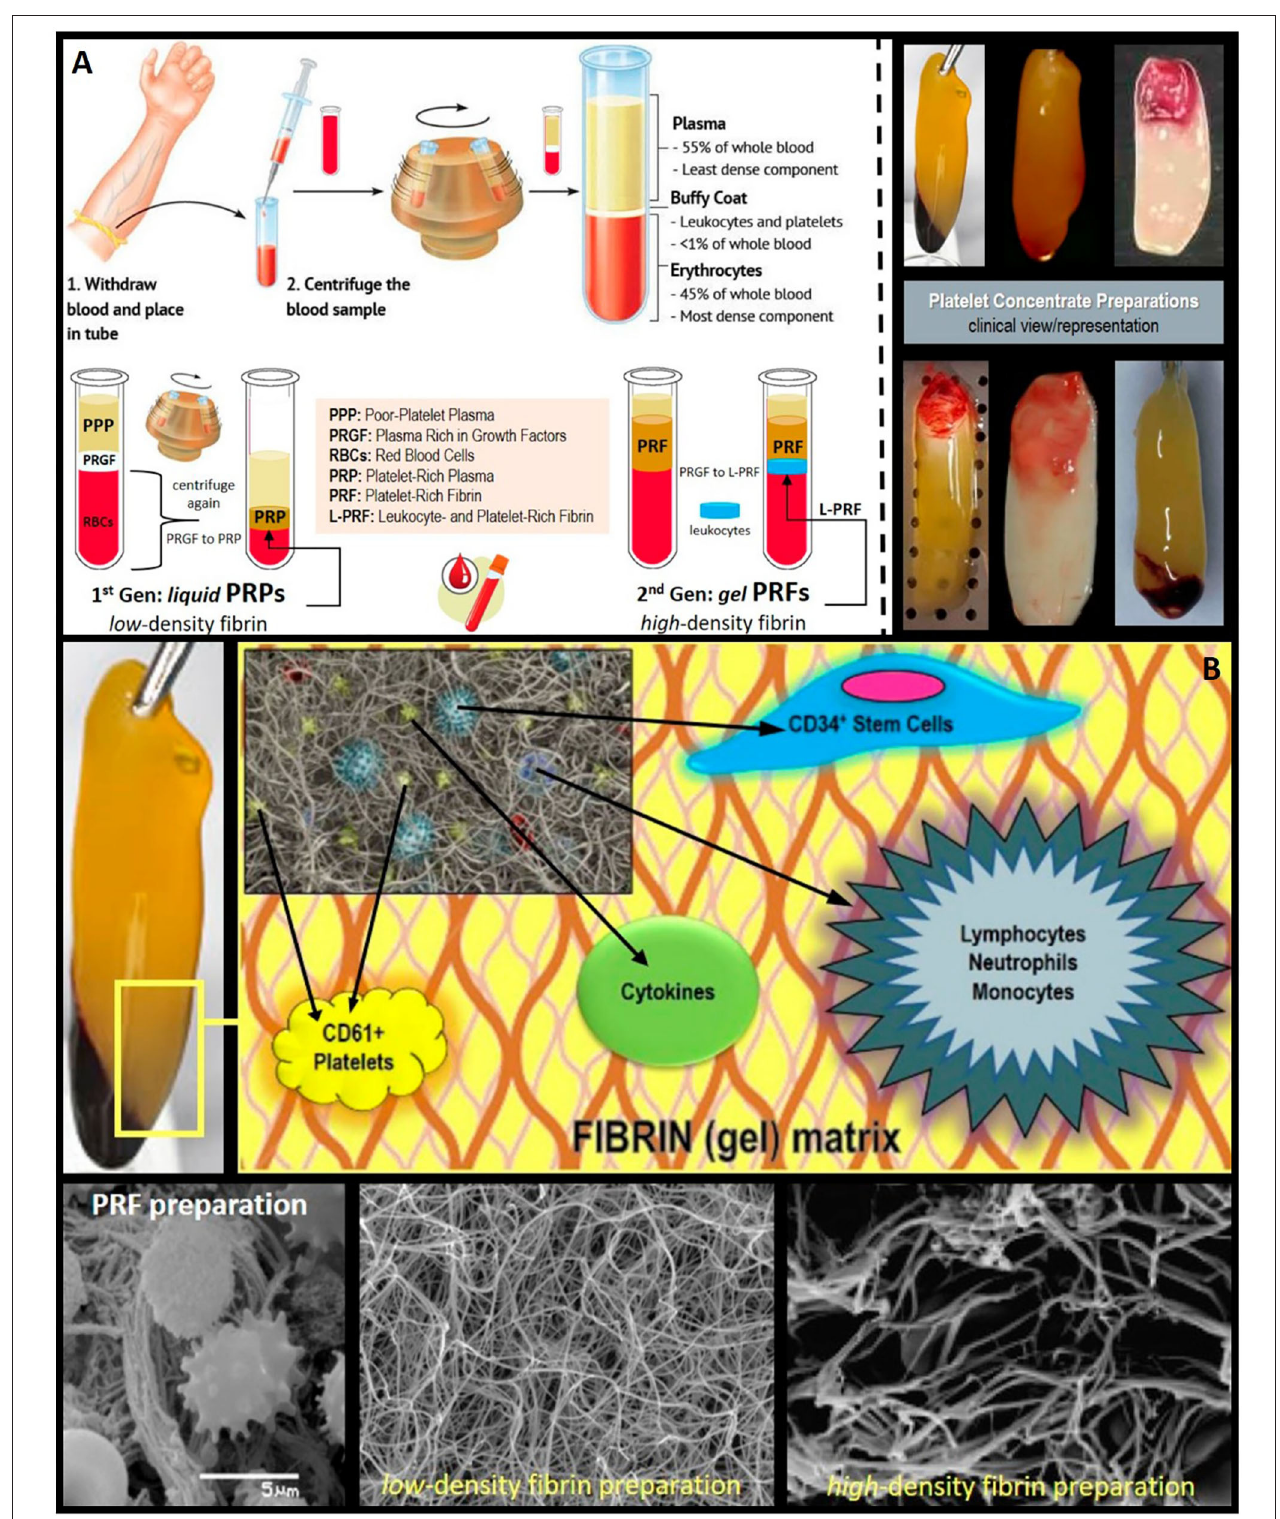
FIGURE 1 | Clinical and histological presentation of L-PRF. (A) Platelet concentrates’ clinical preparation, types/classes, and clinical illustration/presentation of several platelet-rich fibrin (PRF) and leukocyte and platelet-rich fibrin (L-PRF) preparations (membranes). (B) PRF composition/architecture illustration. Schematic representation of PRF bio-components and SEM (scanning electron microscope) micrographs of the PRF membranes displaying its polymerized interconnected fibrin network and large living cell population content.